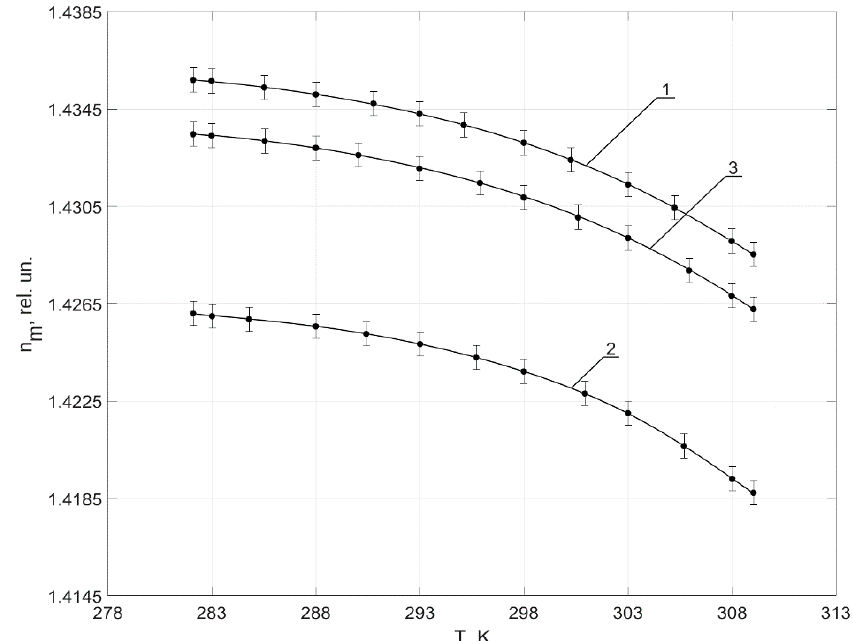
Figure 6. The dependence of the change in the refractive index n m of different gasolines and their mixtures on temperature T. Graphs 1, 2, and 3 correspond to: gasoline of AI-95 brand; gasoline of AI-92 brand; and gasoline mixture of AI-95 and AI-92 brands in a proportion of 0.7 to 0.3. After that, we measured the values of the refractive index for the upper layer n (cid:2923)(cid:2930) = 1.3861 ± 0.0004 (at Т = 297.9 К ) and bottom layer n (cid:2923)(cid:2912) = 1.4246 ± 0.0004 (at Т = 297.9 К ) in